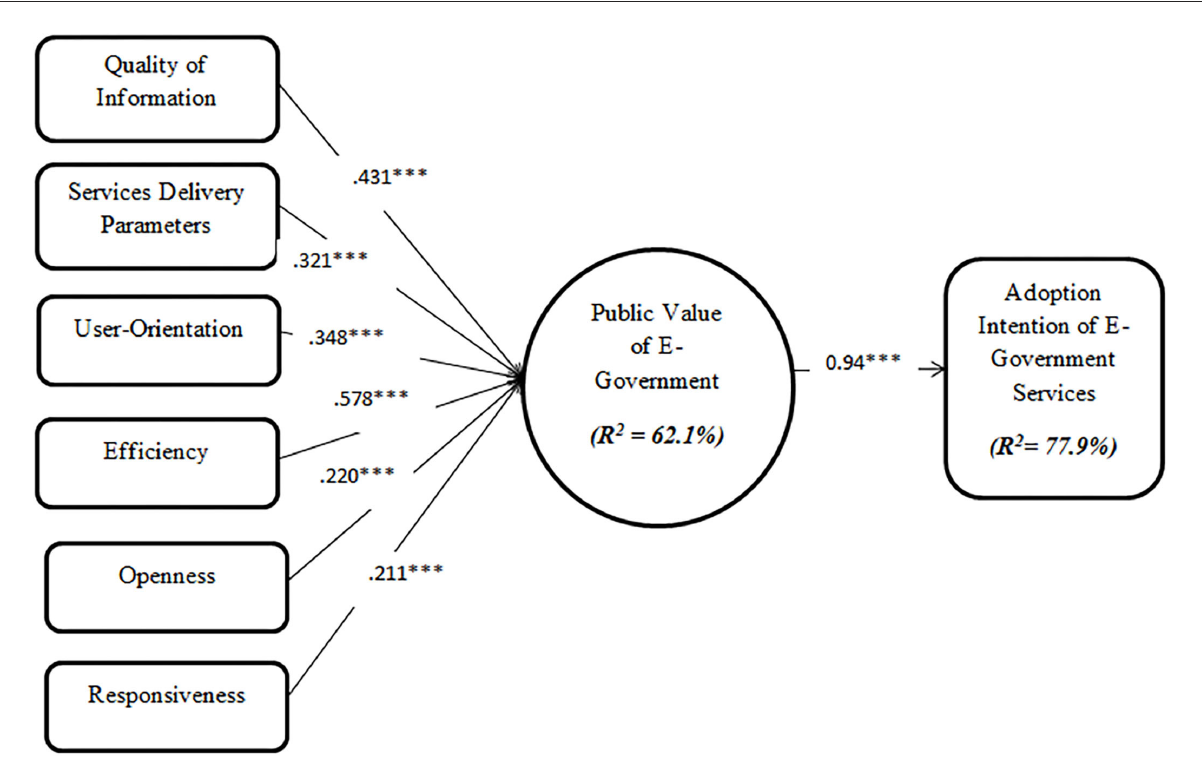
FIGURE4 Validated research